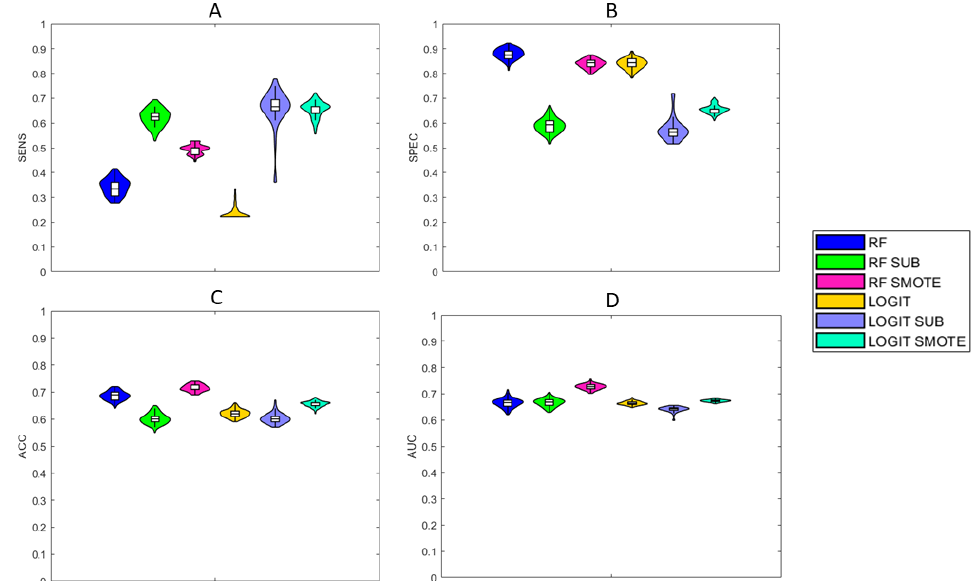
Figure 2. Performance metrics across the cross-validation rounds for each classification scheme: violin plots of the distributions of the sensitivity values ( A ), specificity values ( B ), accuracy values ( C ), and AUC values ( D ).